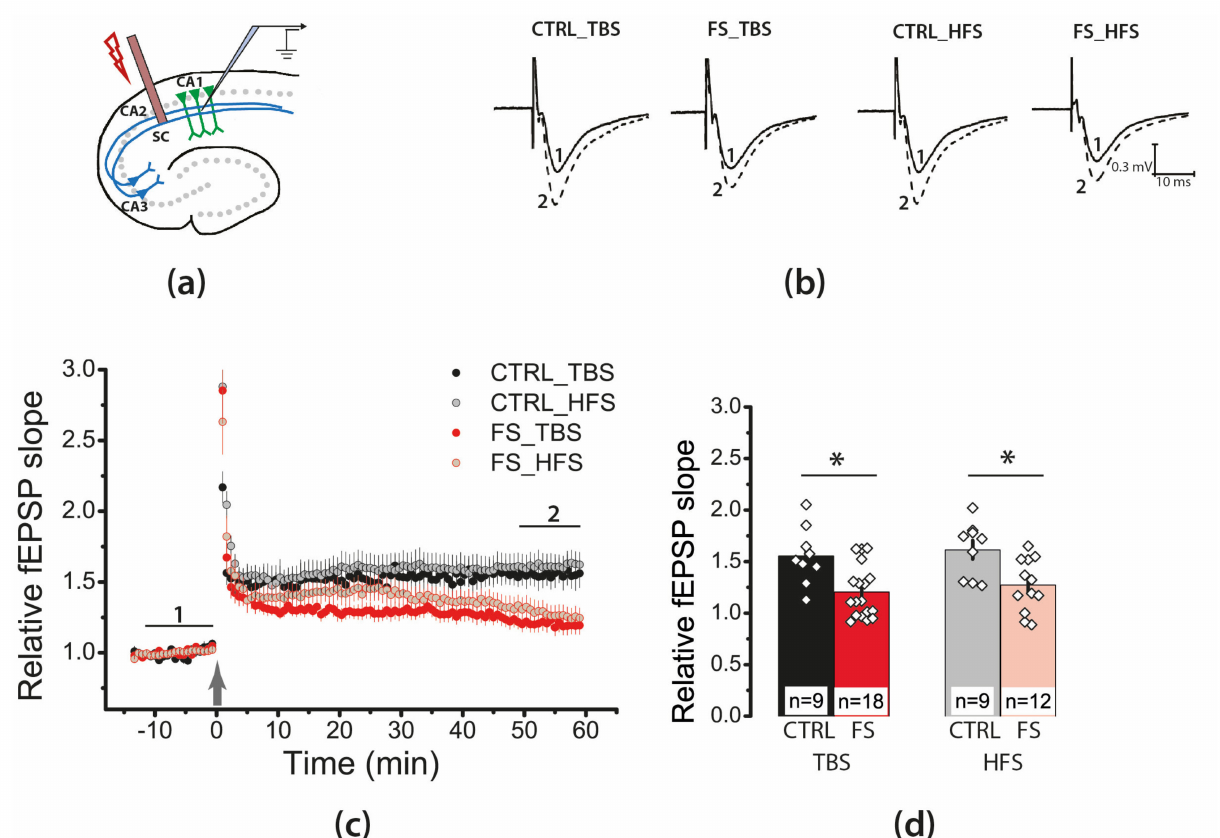
Figure 4. Long-term synaptic potentiation (LTP) was weakened in the CA1 of juvenile rats’ hippocampus after early life FSs. ( a ) Schema showing the positions of electrodes in the hippocampus. ( b ) Representative examples of fEPSP before induction (1) and 60 min after HFS or TBS (2). ( c ) Diagram showing changes in the value of the normalized slope of fEPSP in control (CTRL) and experimental (FS) animals after theta-burst stimulation (TBS) or after high-frequency stimulation (HFS) (stimulation was carried out at time 0). ( d ) Diagram illustrates the differences in LTP between control (CTRL) and experimental (FS) animals with different stimulation types. All data in this and the following figures are presented as a mean ± standard error of the mean. * p < 0.05—the significant difference with the control group (Tukey’s post hoc